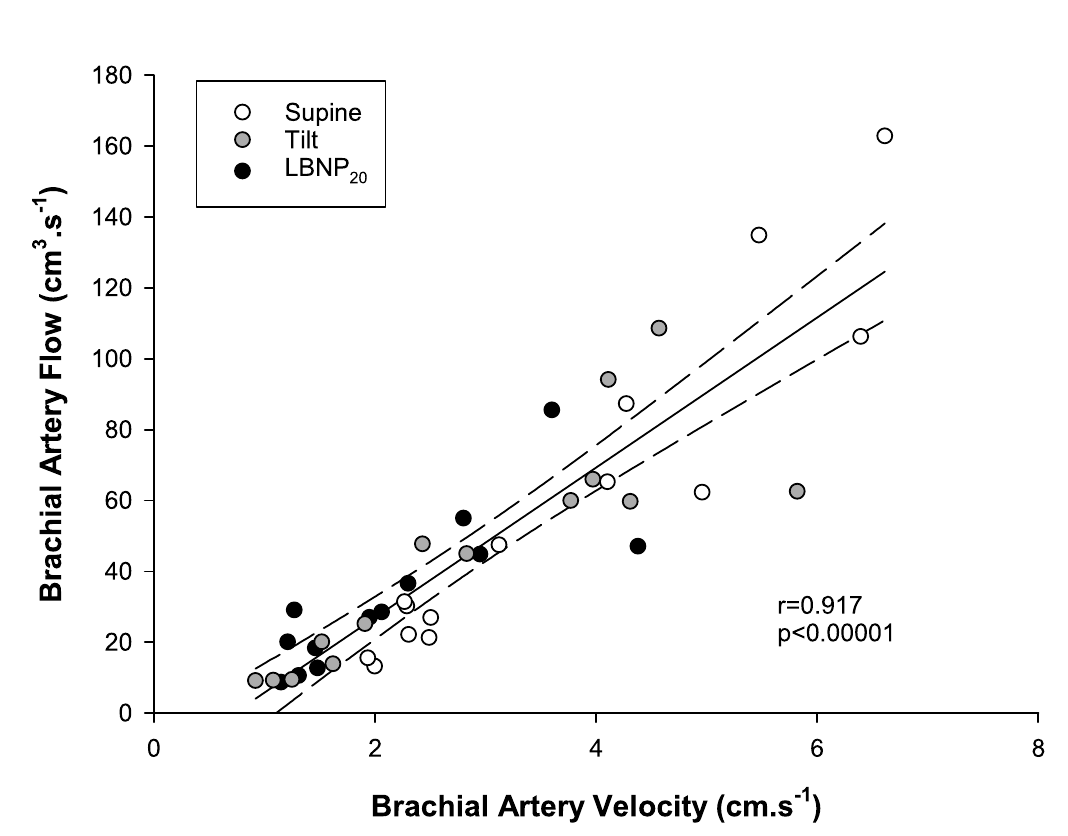
Fig 2. Relationship between simultaneous measurements of brachial artery velocity and flow at baseline and during orthostatic stress. There was a strong correlation between measurements of brachial artery velocity and flow at the end of the supine period (Supine, white), head-upright tilt (Tilt, grey) and head-upright tilt with combined -20mmHg lower body negative pressure (LBNP 20 , black).